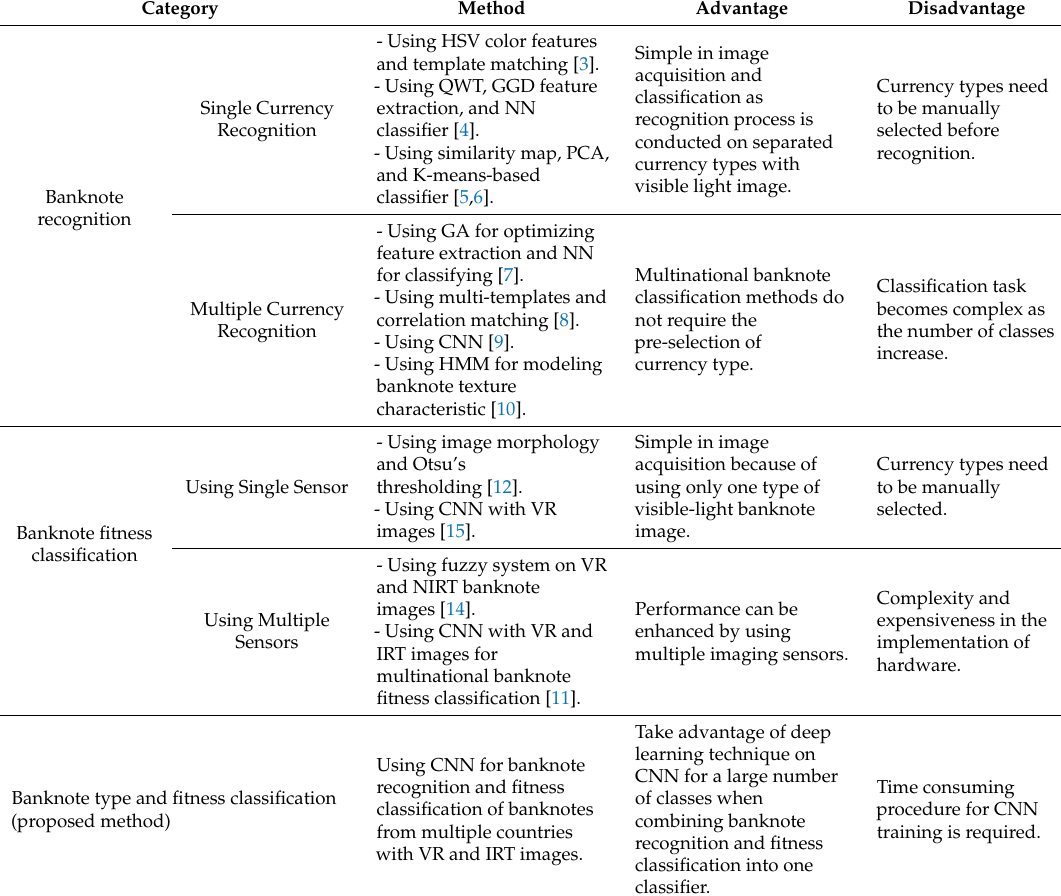
Table 1. Summary of related works on banknote recognition and fitness classification considering the variety of currency